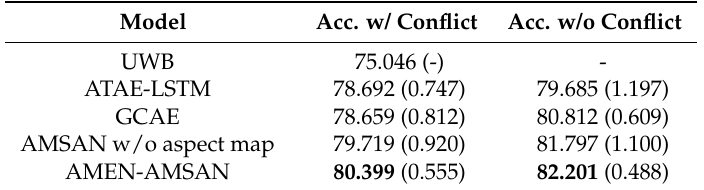
Table 3. Performance comparison of the proposed model with its baselines on the laptop dataset of SemEval-2016.